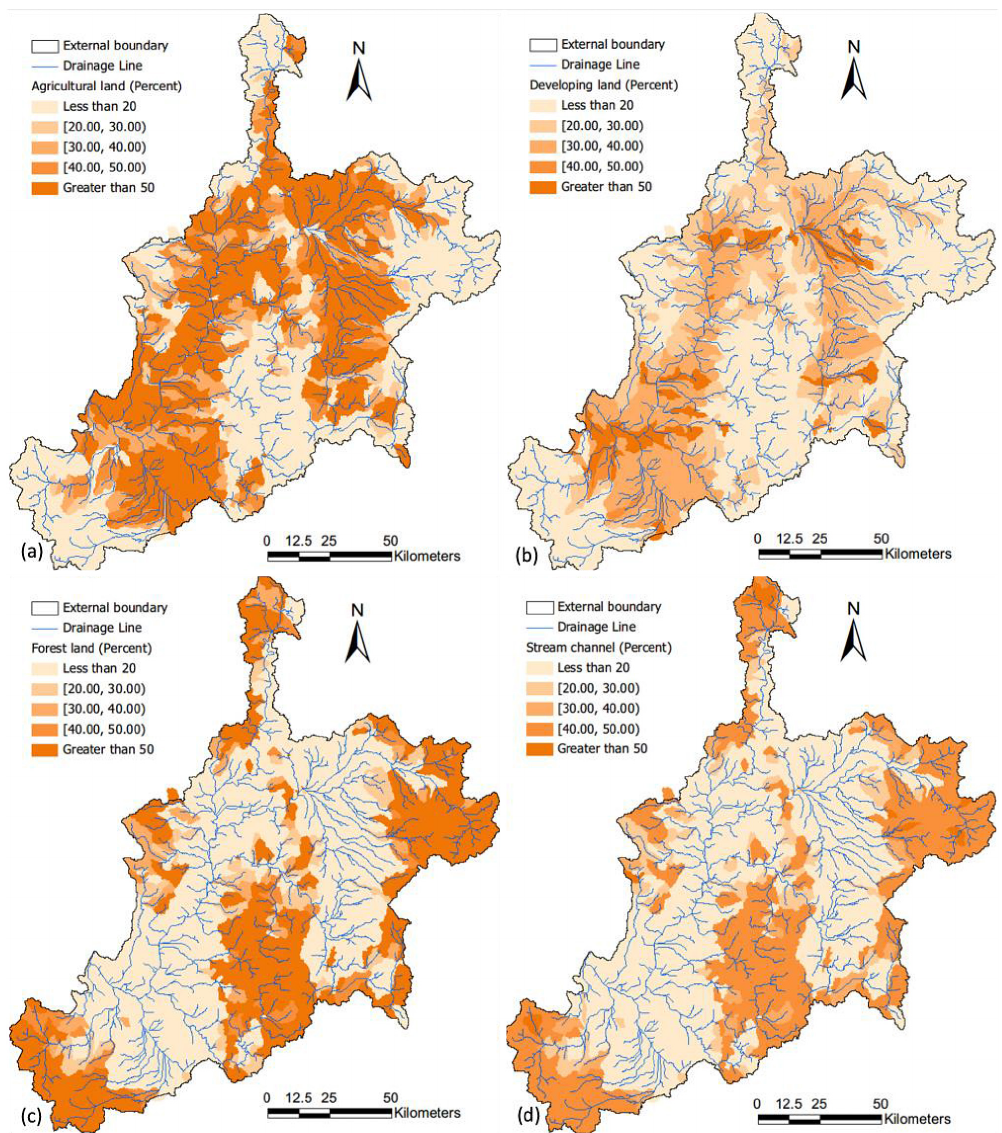
Figure 9. Maps showing the spatial distributions of independent sediment sources generated in each incremental catchment for (a) agricul- tural land, (b) developing land, (c) forested land, and (d) stream